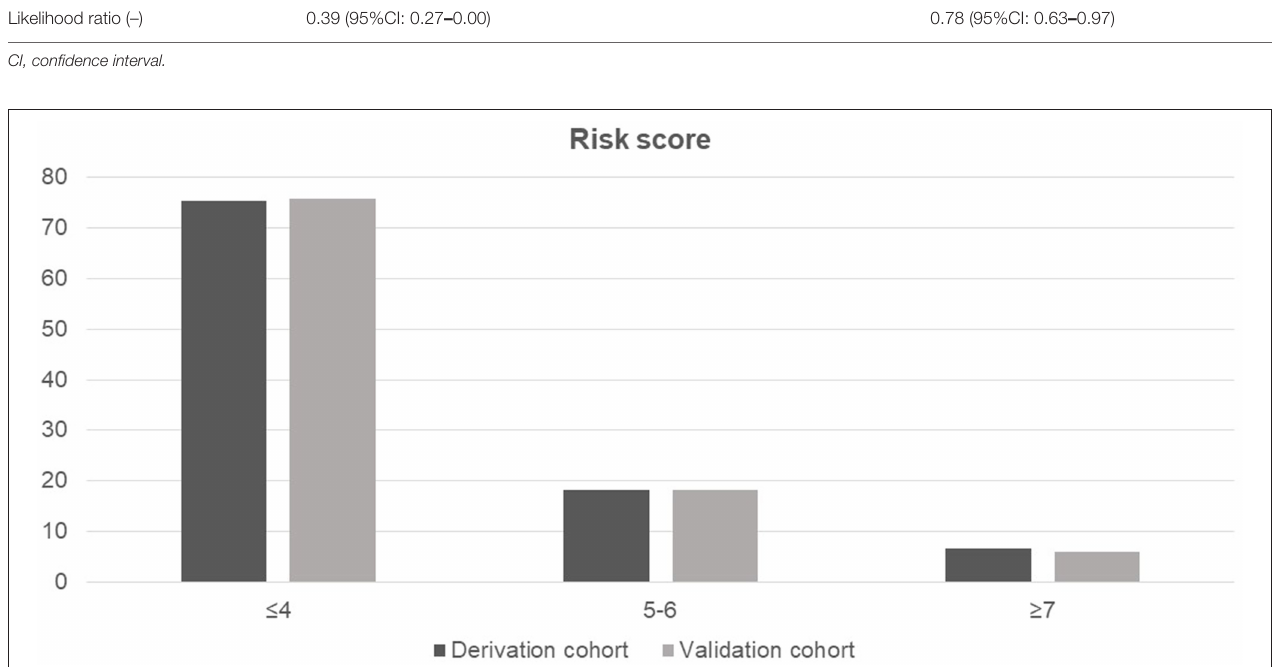
FIGURE 2 | Probability of amputation in patients with necrotizing fasciitis stratified by risk score and compared between the derivation and validation cohorts. with moderate accuracy (NPV 34.75%). The accurate prediction of amputation or no amputation was (224 + 7)/(237 + 19) = 90.23%, whereas the incorrect prediction rate was (13 + 12)/(237 + 19) = 9.76% ( Table 5